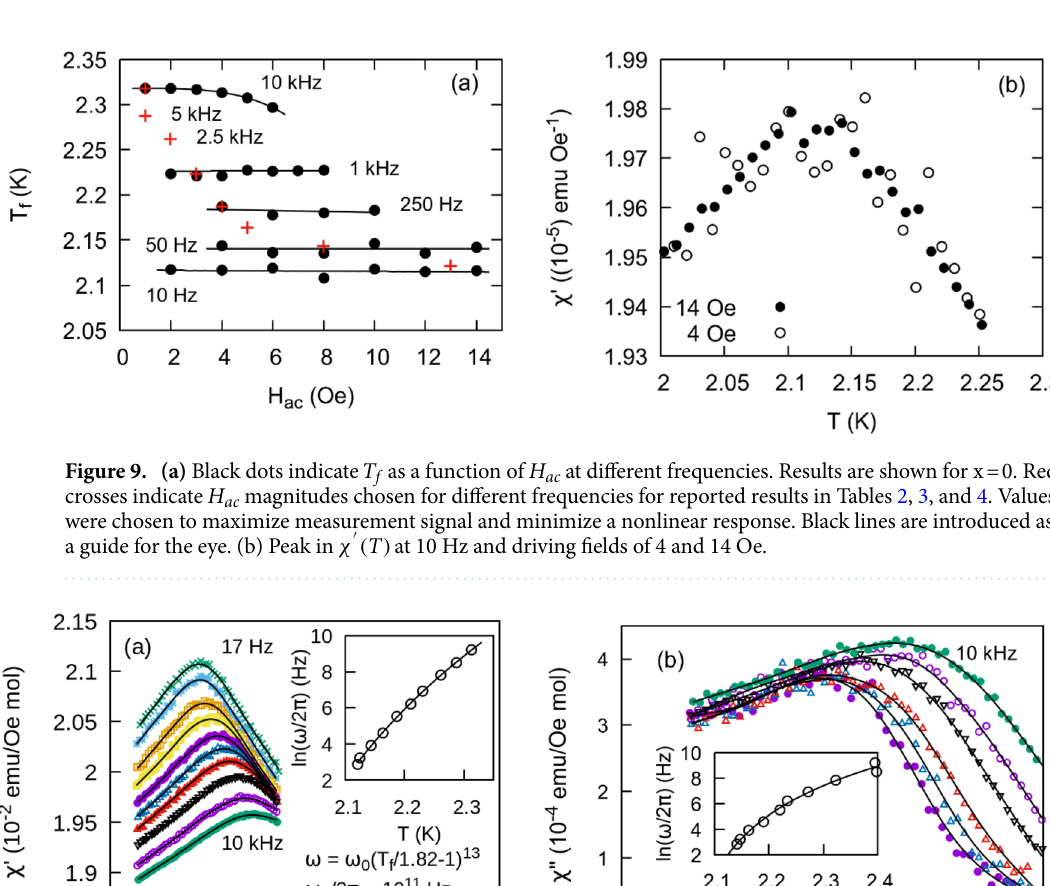
Table 3. Same parameters as those in Table 2 with H ac varying as indicated in Fig. 9a.